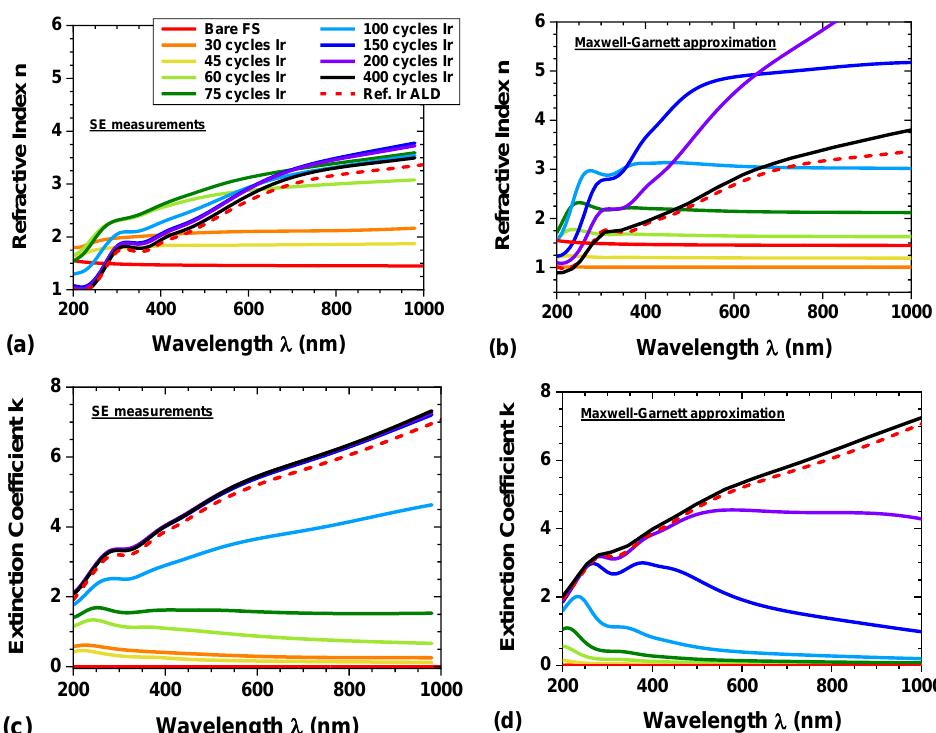
Figure 2. Optical constants of Ir coatings with different numbers of ALD cycles from the 200 to 1000 nm wavelength. The refractive index and extinction coefficient were evaluated by fitting ( a , c ) spectral ellipsometry (SE) measurements and modeled using ( b , d ) the Maxwell Garnett (MG) theory. Additionally, the effective optical constants were numerically simulated using the Maxwell Garnett (MG) approach, wherein spherical Ir NPs are embedded in a host (air) matrix. Figure 2b provides a rough estimation of these dispersion profiles showing an increasing trend in the refractive index n as the Ir surface coverage increases. However,